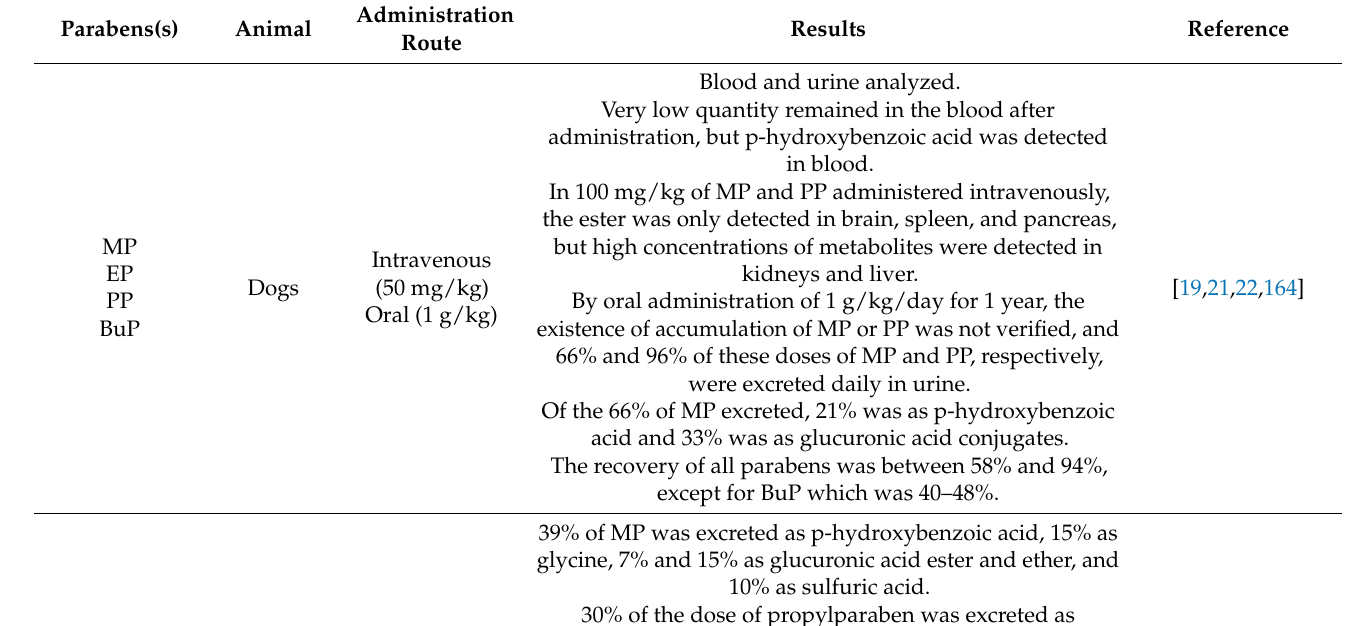
Table 7. Detection, metabolization and extraction of parabens in humans.